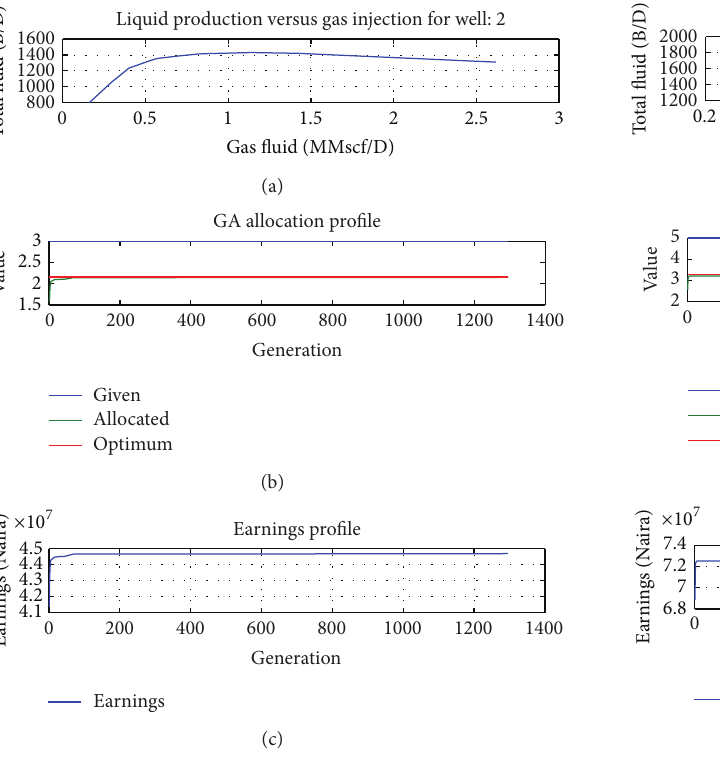
Figure 9: Well 2’s allocation profile, wells 1-2 GA allocation profile, and wells 1-2 earnings (Naira) in an unlimited scenario.